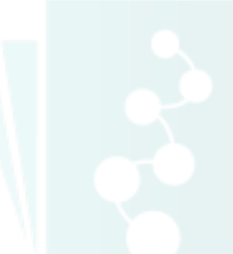
Figure 1: Risk-Utility map indicating the nature of the trade-off between confidentiality protection and statistical usefulness for a range of popular current